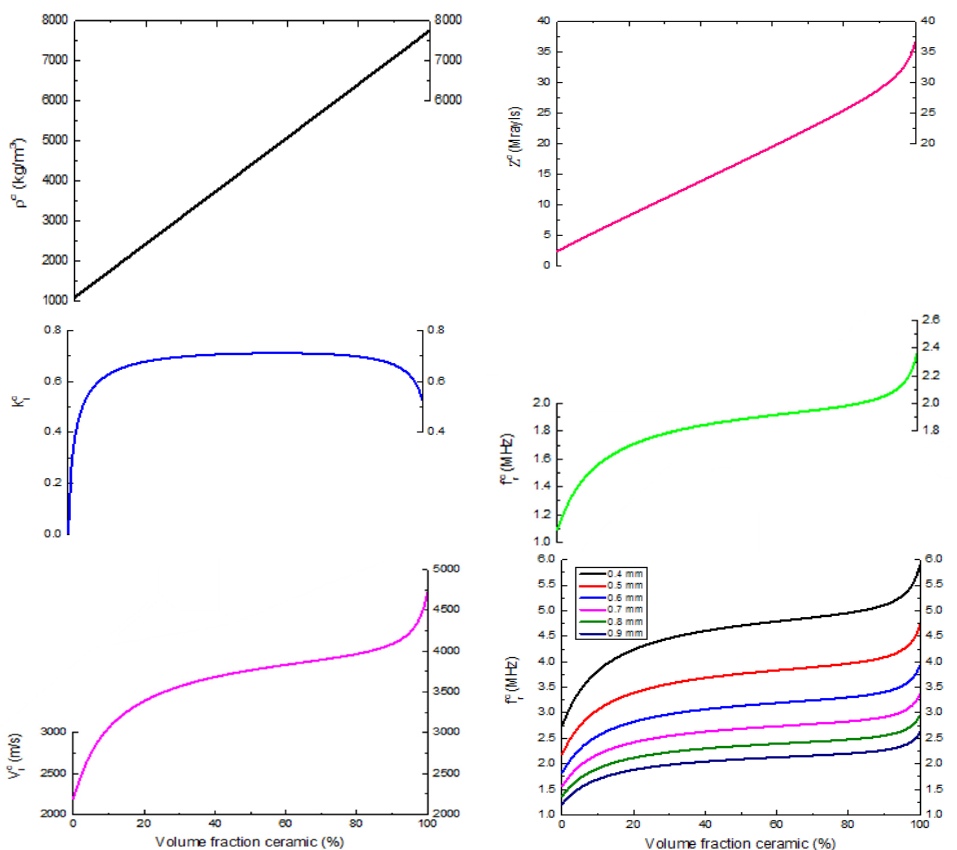
Figure 3. Variation in the effective properties with piezoceramic volume fraction. Table 3. Acoustic properties of fabricated 2-2 composite.